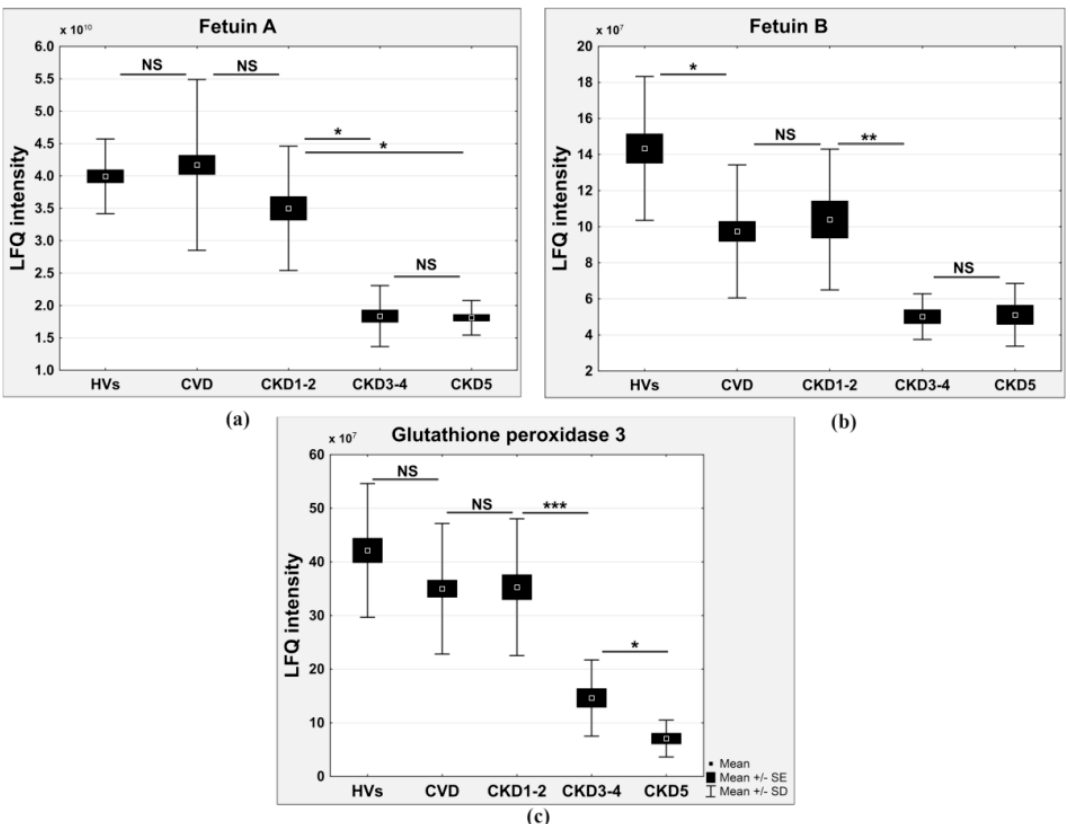
Figure 4. Relative abundance of fetuin A ( a ) fetuin B; ( b ) and glutathione peroxidase 3; ( c ) in HVs, CVD, CKD1-2, CKD3-4, and CKD5 groups. Student’s t -tests were completed and statistical significance is indicated (* p < 0.05, ** p < 0.001, *** p < 0.0001, NS: non-significant). Int. J. Mol. Sci. 2016 , 17 , 631